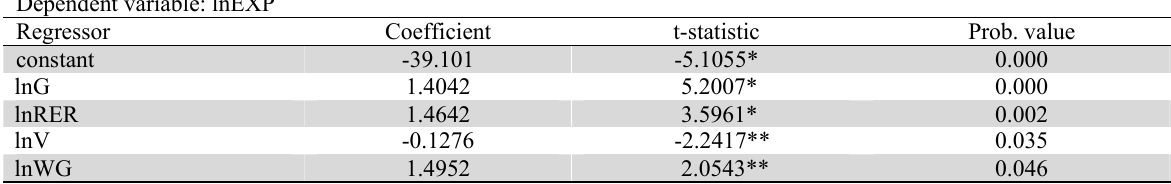
Estimated Long-Run Coefficients Using the ARDL(3,3,0,1,3)